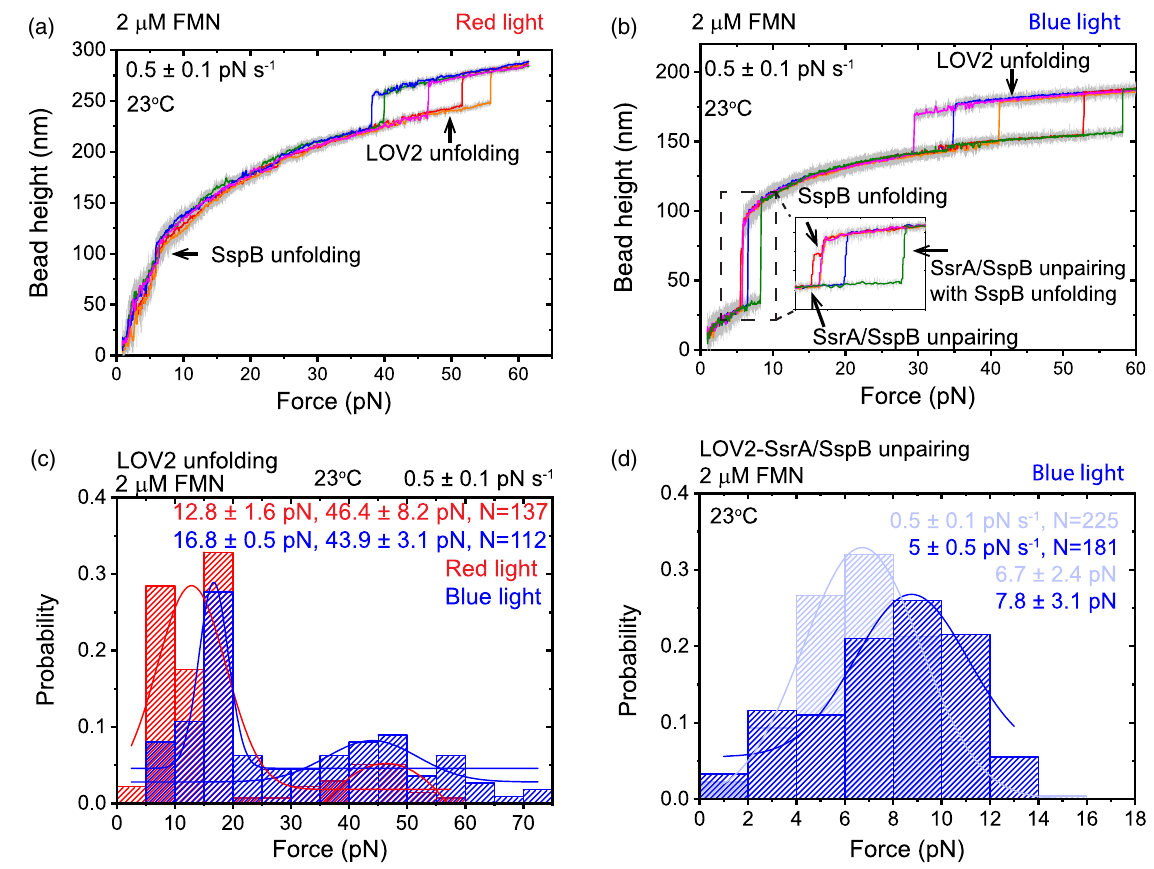
FIG. 3. Mechanical stability of the FMN-LOV2-SsrA/SspB complex. (a),(b) Five representative force-extension curves of the FMN- LOV2-SsrA/SspB complex obtained at a force-loading rate of 0 . 5 (cid:1) 0 . 1 pN s − 1 with 2 μ M free FMN in solution, in red light and in blue light [collimated blue LED array (approximately 1 mW × cm − 2 at 470 nm) [7] ], respectively, indicated by multiple colors. The color lines are 20-FFT smooth of the raw data (gray). (c) Normalized histograms of LOV2 unfolding forces obtained in red light (red)and blue light (blue), with 2 μ M free FMN in solution. (d) Normalized histograms of FMN-LOV2-SsrA/SspB complex unpairing forces obtained in blue light at force-loading rate of 0 . 5 (cid:1) 0 . 1 and 5 (cid:1) 0 . 5 pN s − 1 . N indicates the number of data points obtained. The colored lines in (c) and (d) are corresponding Gaussian fitting